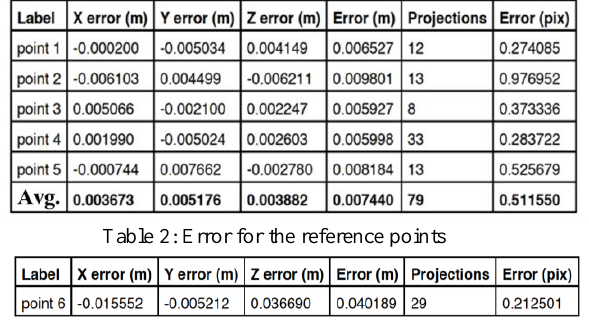
Table 3: Error for the control point